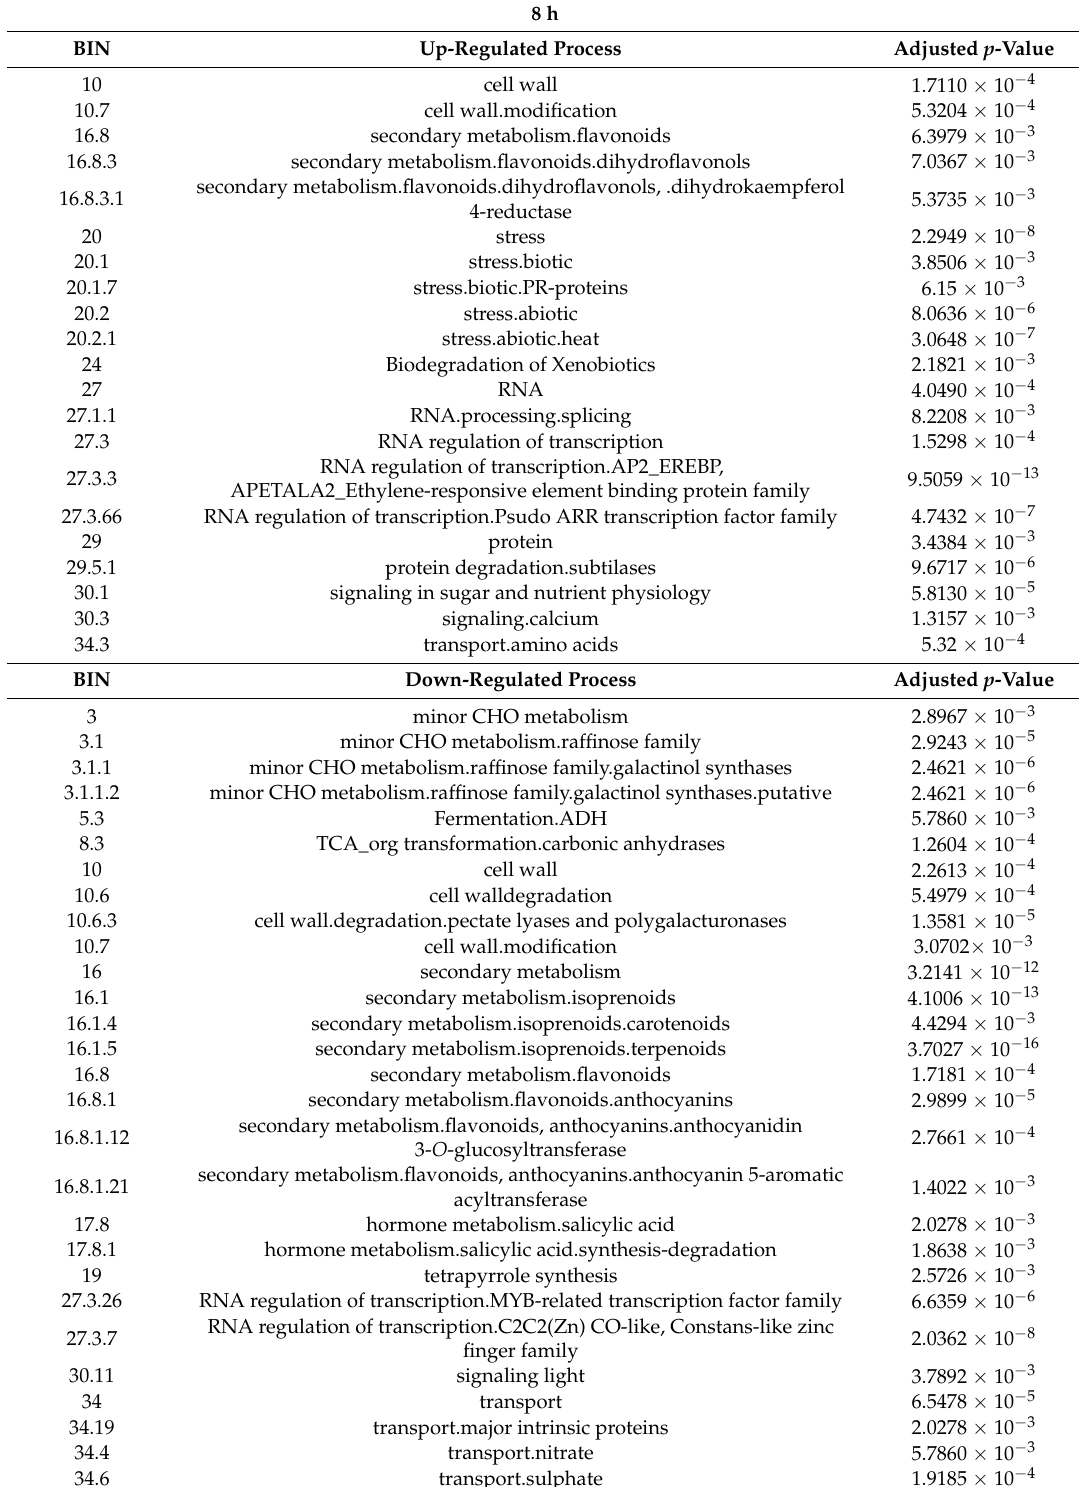
Table 1. Major functional categories highly impacted by the cold night at 8 h according to Corto